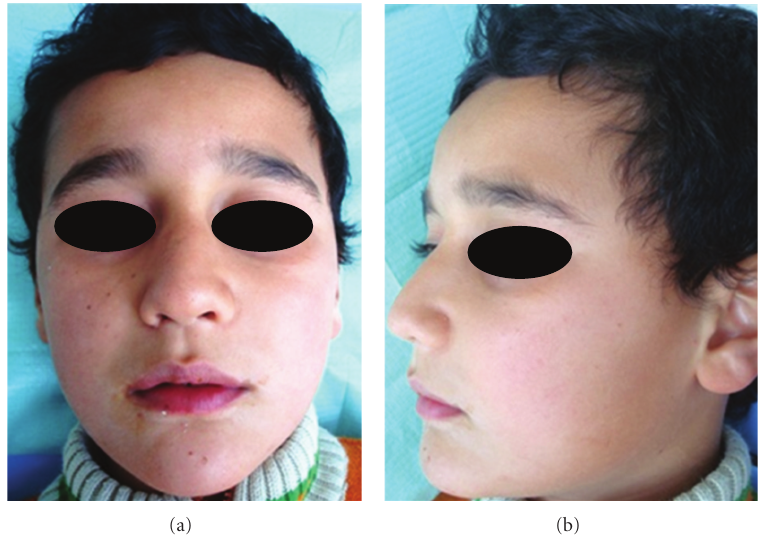
Figure 13: Postoperative frontal view and lateral view after 2